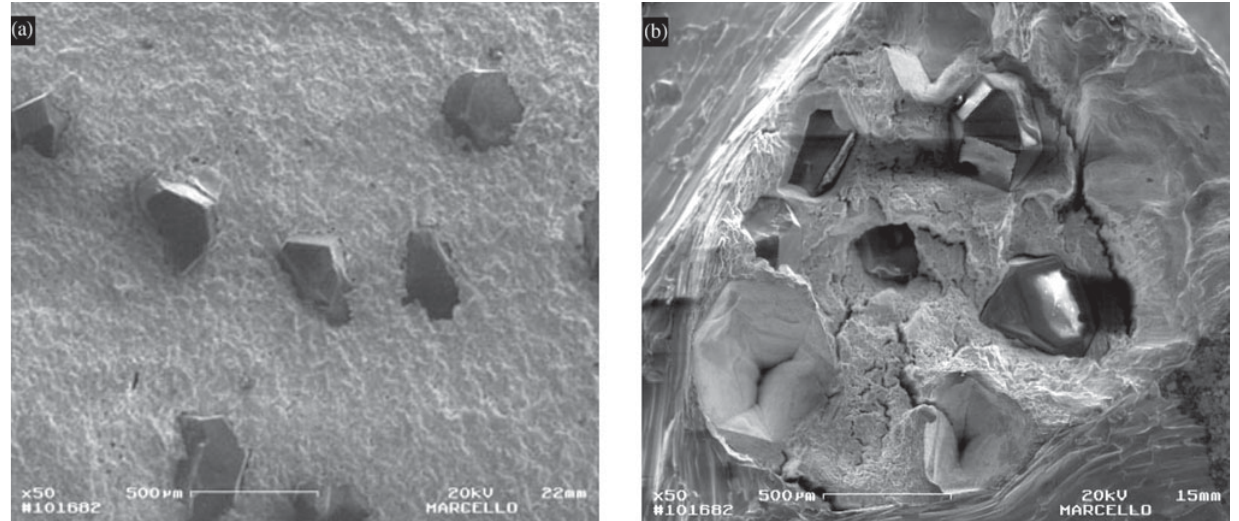
Figure 2. (a)Longitudinal section of the sintered bronze 4 wt.% diamond, ∅ = 8.00 mm, and (b) cross section of diamond composite, ∅ = 1.84 mm.